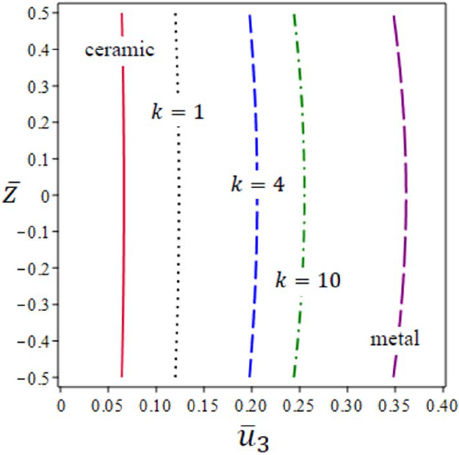
Figure 8: The transverse displacement across the thickness of a FG